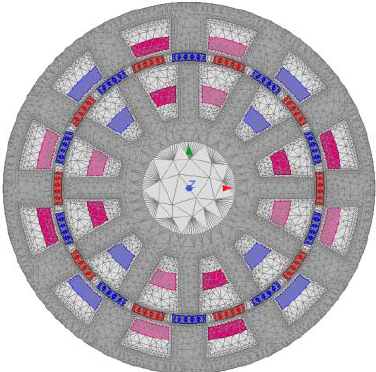
Figure 2. Mesh layout for 2D FEM